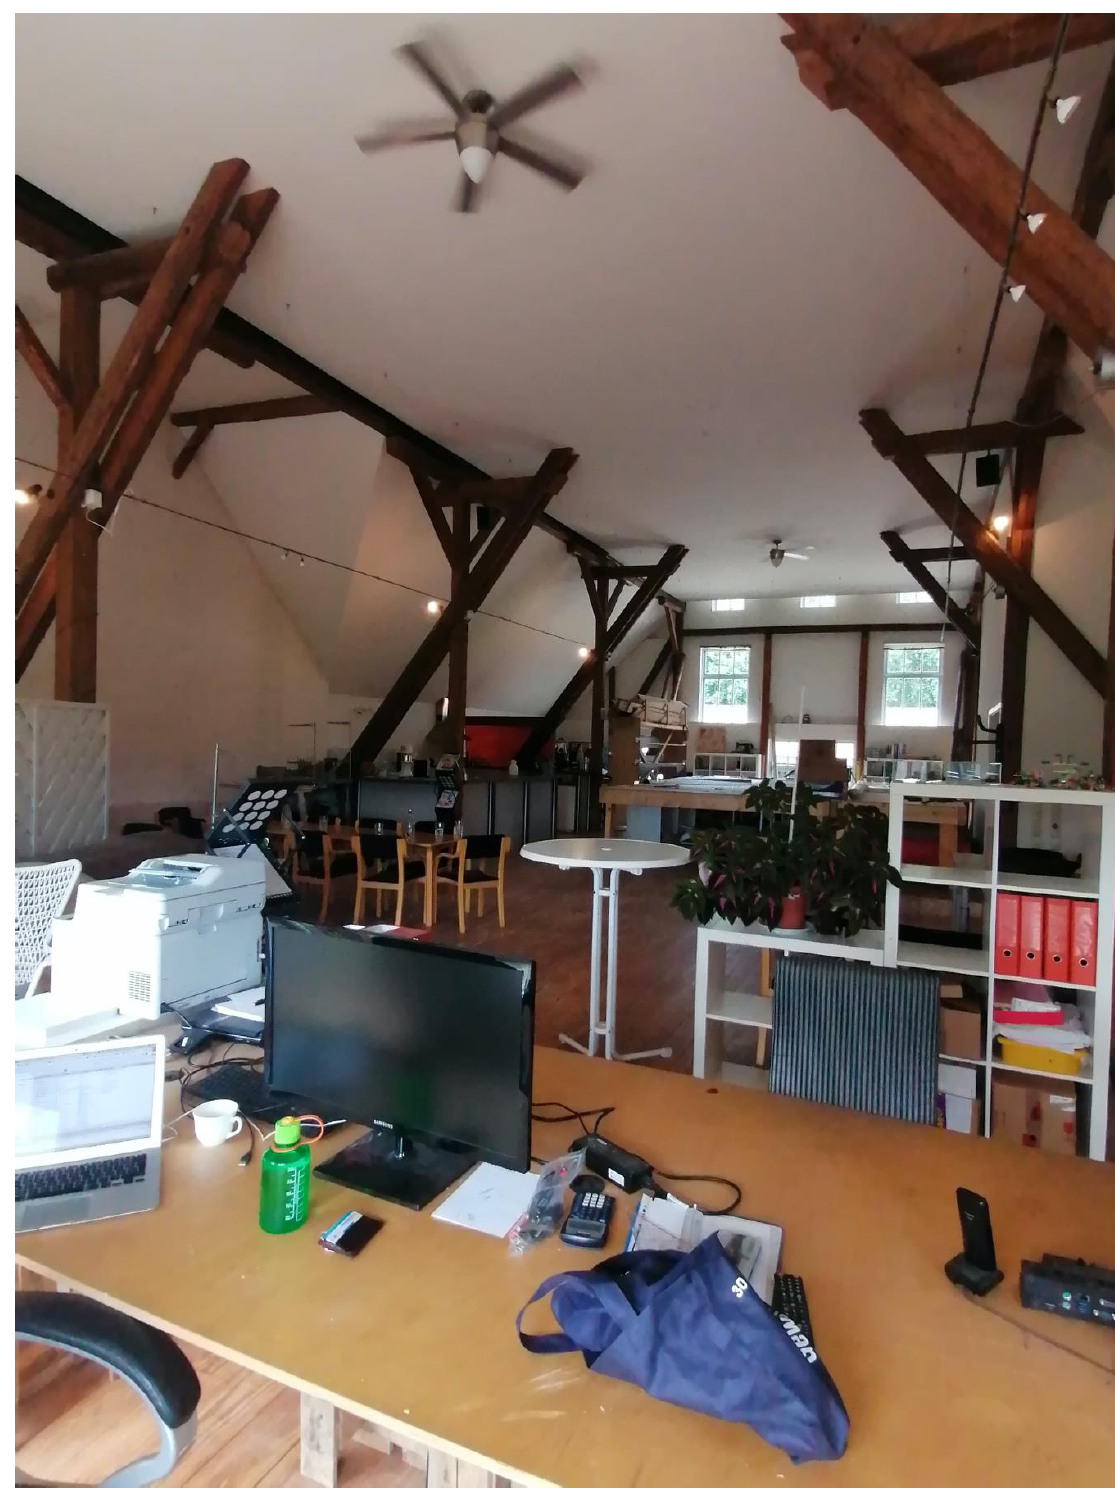
Figure 8. Coworking space in a village, former hayloft, interior view.